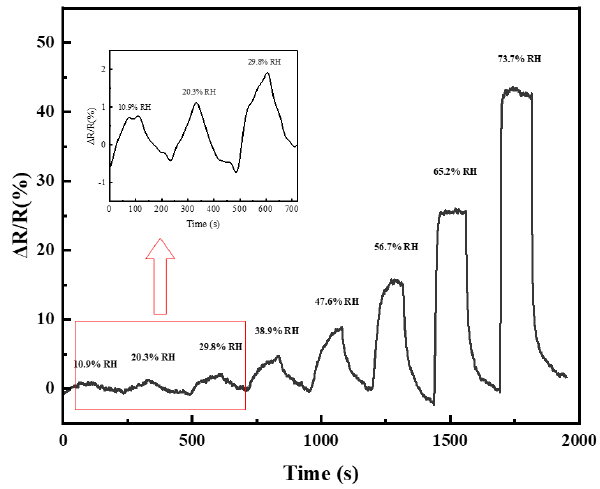
Figure 8. Response change of humidity sensor in different concentrations.